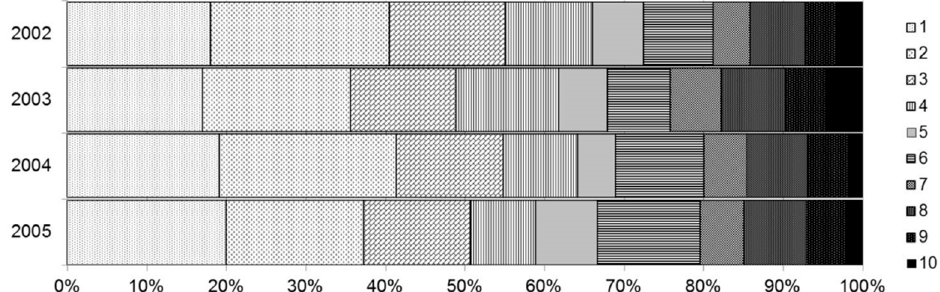
Figure 2. Shares of ten basal area classes in the total canopy transpiration during the 2002, 2003, 2004, and 2005 growing seasons (class 1 = dominant, class 10 = suppressed).